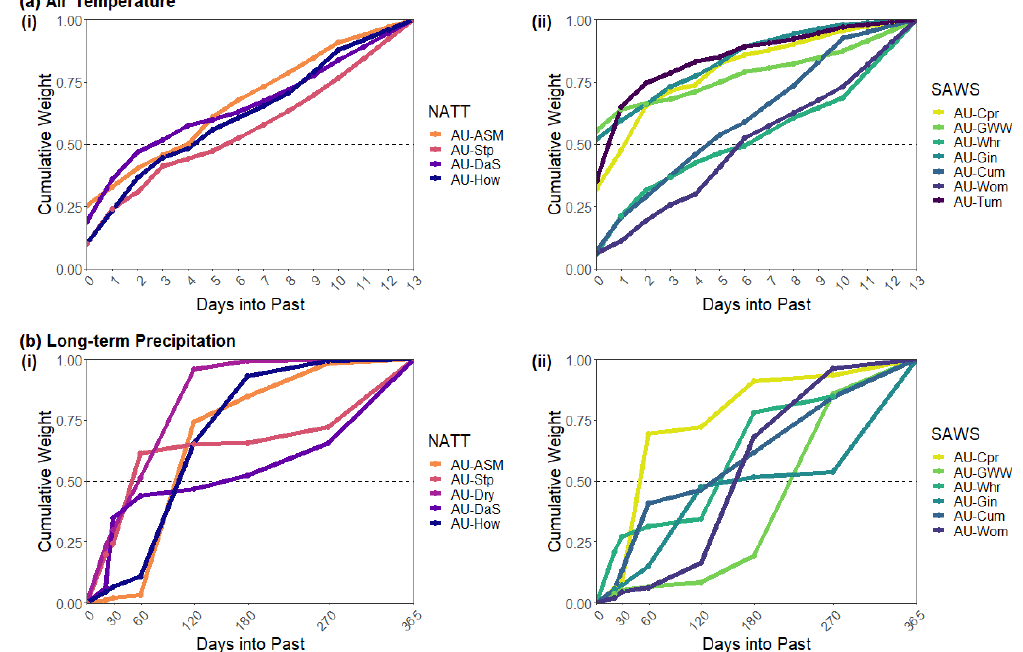
Figure 4. Cumulative mean weights from the λE EM model for (a) air temperature and (b) long-term precipitation. Sites are split into the (i) NATT and (ii) SAWS groups for each climate predictor. Within each group, sites are ordered by mean annual precipitation, with darker colours indicating higher MAP. Only sites where the climate variable is significant in Fig. 2b are included. The dashed line at a cumulative weight of 0.5 indicates the threshold for the critical lag period. Where the cumulative weights cross this line is considered the timescale of the environmental memory effect for each site for the climatic driver in